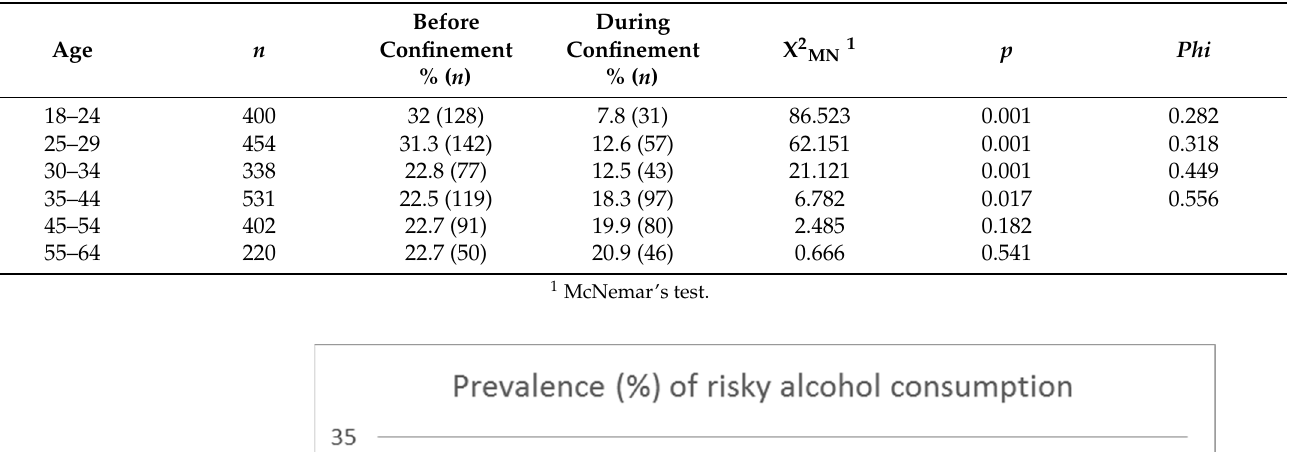
Table 3. Proportion of risky alcohol consumption by age before and during confinement ( n = 2345).